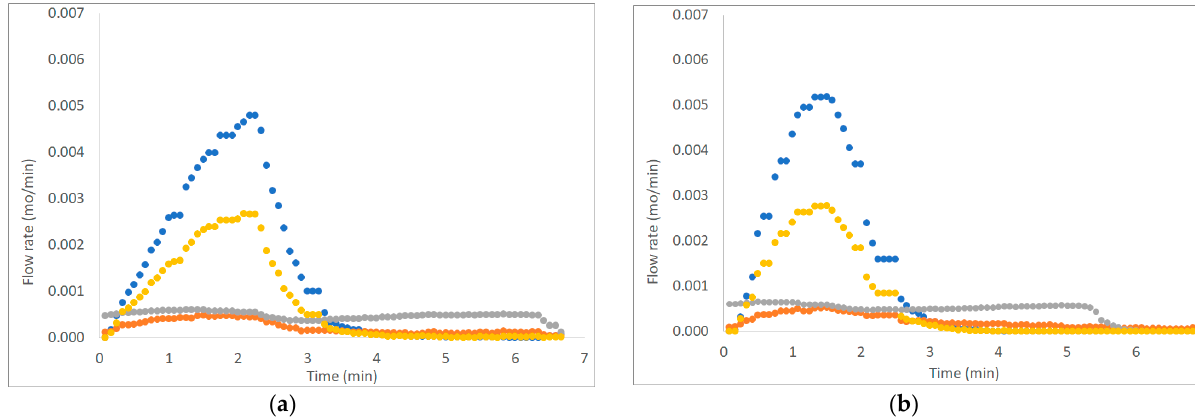
Figure 4. Example of H 2 , CO, CO 2 , and CH 4 outlet molar flow rates ( F i , out ) as functions of time ( t ), produced by devolatilization tests of ( a ) chirurgical masks and ( b ) FFP2 mask, in a fluidized bed reactor at 700 °C, in nitrogen and air atmosphere. ( ● H 2 , ● CO, ● CO 2 ; ● CH 4 ).